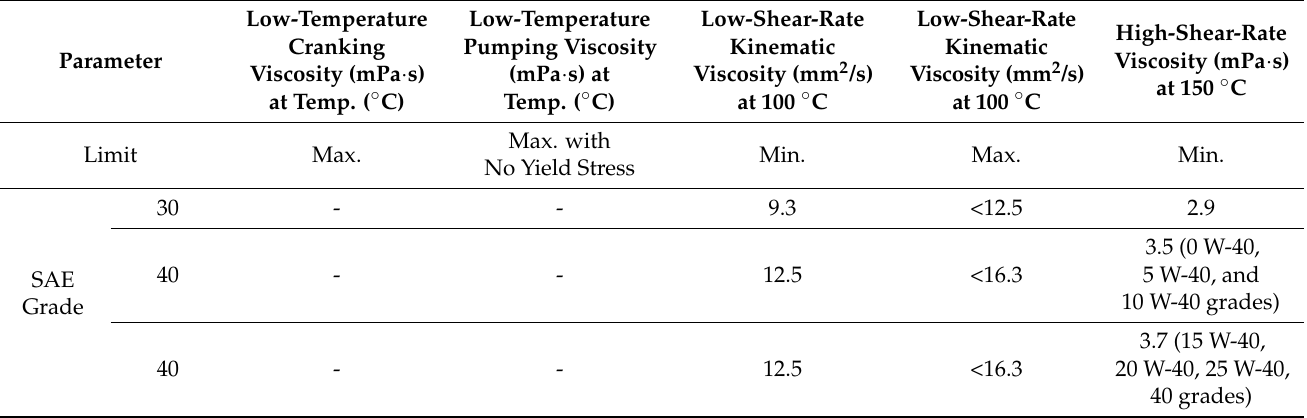
Table A1. SAE J300-2021 classification based on viscosity for engine oils for SAE 30 and SAE 40 grades (based on [46]).